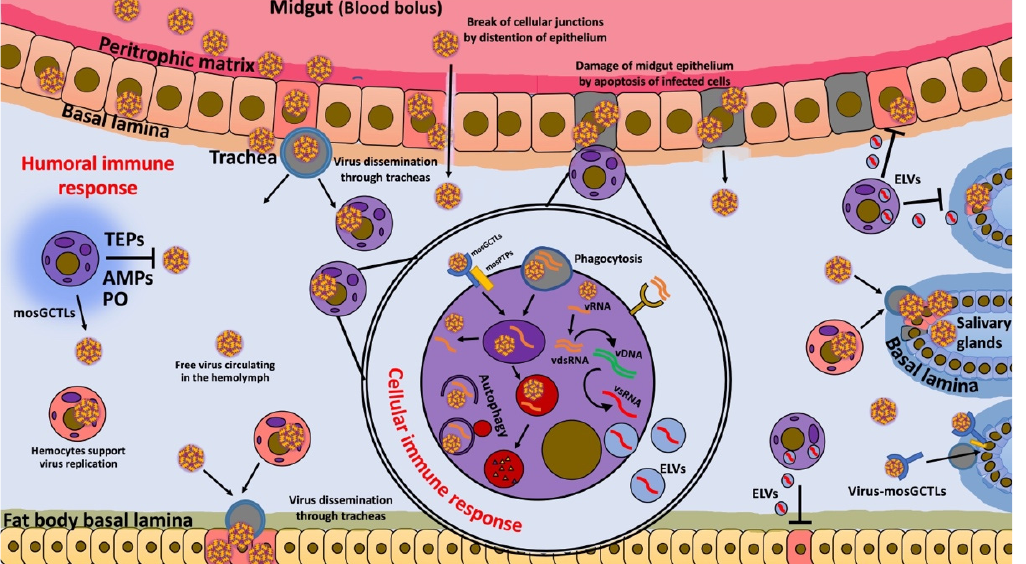
Figure 1. Hemocytes’ immune response during viral infections. Hypothetical model of possible functions of hemocytes during viral infection. Blood meal contains viruses that trigger the production of digestive enzymes and midgut distention, which disrupt cellular junctions and cause apoptosis in midgut epithelium cells (gray square cells). These effects facilitate virus dissemination, al- lowing infection of cells and trachea via gaps in the cellular junctions and via apoptosis of cells. Viruses released from the midgut epithelium can be freely transported in the hemolymph or by infected hemocytes (circular purple (uninfected) and pink cells (infected)) that are distributed in the flowing hemolymph to secondary tissues, such as fat bodies and salivary glands, which receive the virus through the tracheal system. Hemocytes can facilitate the entry of a virus into cells of various tissues through the production of mosquito galactose-specific C-type lectins (mosGCTLs) and pro- tein tyrosine phosphatases (mosPTPs). However, hemocytes also produce phenoloxidase (PO), an- timicrobial peptides (AMPs), and thioester-containing proteins (TEPs), which are involved in virus elimination. In addition, in the later stages of infection, hemocytes take up free viruses by endocy- tosis or phagocytosis of apoptotic cells, together with cellular debris containing virus and dsRNA; they then develop viral small interfering RNAs (vsRNAs) that are released by exosome-like vesicles (ELVs) to enter infected cells and confer virus resistance through the RNAi pathway. Finally, hemo- cytes can also eliminate viruses by autophagy. For many years, one of the main limitations in hemocyte research was the scarcity of sensitive and accurate tools to examine these cells. Adult mosquitoes have only 2000–5000 hemocytes, so the use of suitable strategies and technologies is particularly critical. Re- cently, many new tools have been developed for the study of hemocytes, such as intravital staining, which allows the monitoring of hemocytes in vivo [32]. Single-cell RNA sequenc- ing has allowed the identification of different subpopulations in mosquitoes and their spe- cific mechanisms of immune response against pathogens such as Plasmodium [109–111]. Furthermore, clodronate liposomes have been used to deplete phagocytic hemocytes in An. gambiae , Ae. aegypti , and Drosophila [119,152]. Finally, a promoter of Drosophila hemo- lectin driving mosquito hemocyte-specific expression has been reported [44]. These new tools will help us to address many questions about hemocyte biology, as well as to identify new strategies for vector-borne disease control. Author Contributions: V.C.-J. and G.D. contributed to the conception, writing and critical revision of the manuscript; V.C.-J., C.V.T. and S.D. contributed to the drafting, writing and critical revision of the manuscript; V.C.-J. and G.D. supervised and edited the manuscript. All authors have read and agreed to the published version of the manuscript. Funding: This work has been supported by the National Institutes of Health grant R01AI141532. Institutional Review Board Statement: Not applicable.